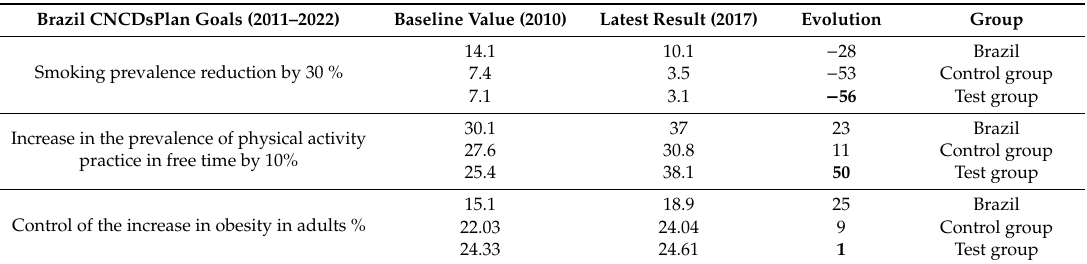
Table 5. Comparative analysis based on the goals of the Strategic Action Plan for Coping with CNCDs in Brazil from 2011 to 2022. (Results with the best performance are in bold.)